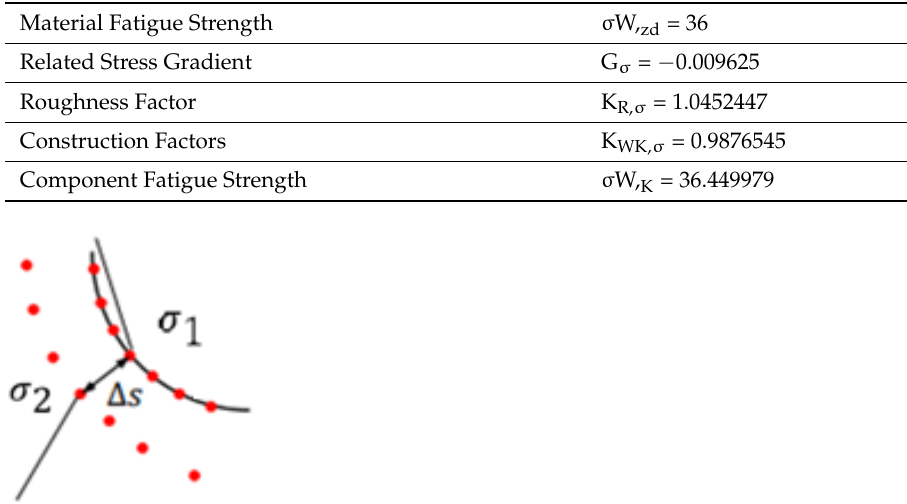
Table 5. Intermediate results of calculations (composition No. 15).